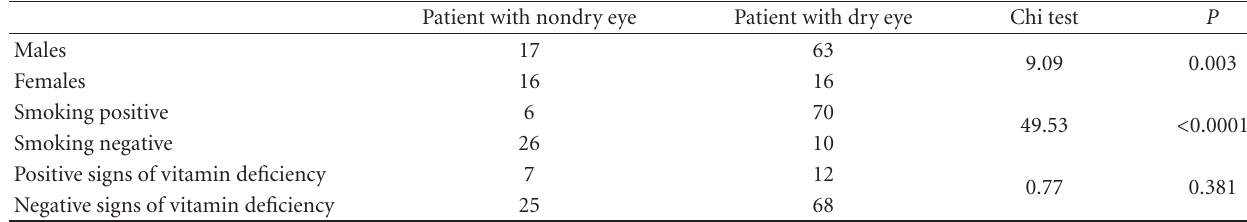
Table 3: Gender, vitamin deficiency, and indoor smoking between dry eye and nondry eye groups. Patient with nondry eye